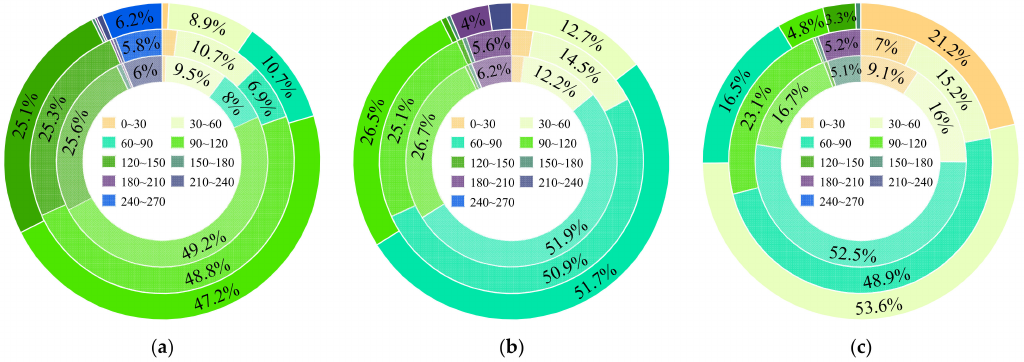
Figure 6. The area proportions of NPP value. The small, medium, and large annuli denote area proportions in 2016, 2017 and 2018, respectively. (The proportion less than 3.0% was not marked. The transparency of the same attribute color decreases by 20% from the inner annulus to the outer annulus). ( a ) July; ( b ) August; ( c )